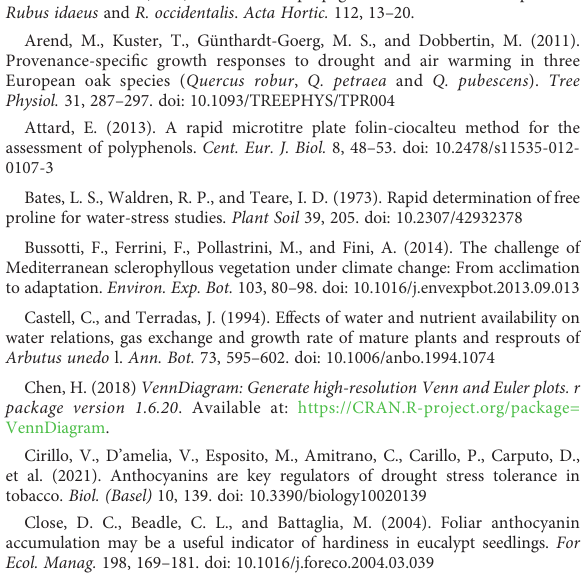
SUPPLEMENTARY FIGURE 1 Average rainfall (mm) from 1970 to 2019 in seven meteorological stations across continental Portugal and location of the four mother plants used for micropropagation (A) and water irrigation conditions, analysis carried out and sample size used on the experiment along the three time points sampled: t1(10 days stress), t2 (20 days stress) andt3 (20 days stressplus 5 days recover) (B) . SUPPLEMENTARY FIGURE 2 Metabolomic analysis on genotypes A2 and A3 at t2 (A-B) and t3 (C-D) : volcano plot for genotype A2 indicating signi fi cantly (p < 0.05 and FC > 2) up- and down-regulated metabolites on water stress group when compared to well-water group (A) , volcano plot for genotype A3 indicating signi fi cantly (p < 0.05 and FC > 2) up- and down-regulated metabolitesonwaterstressgroupwhencomparedtowell-watergroup (B) , volcano plot for genotype A2 indicating signi fi cantly (p < 0.05 and FC > 2) up- and down-regulated metabolites on water stress group when compared to recover group (C) , volcano plot for genotype A3 indicating signi fi cantly (p < 0.05 and FC > 2) up- and down regulated metabolites on water stress group when compared to recover group (D) . Data was normalised by median, cube root transformed and Pareto-scaled (n =